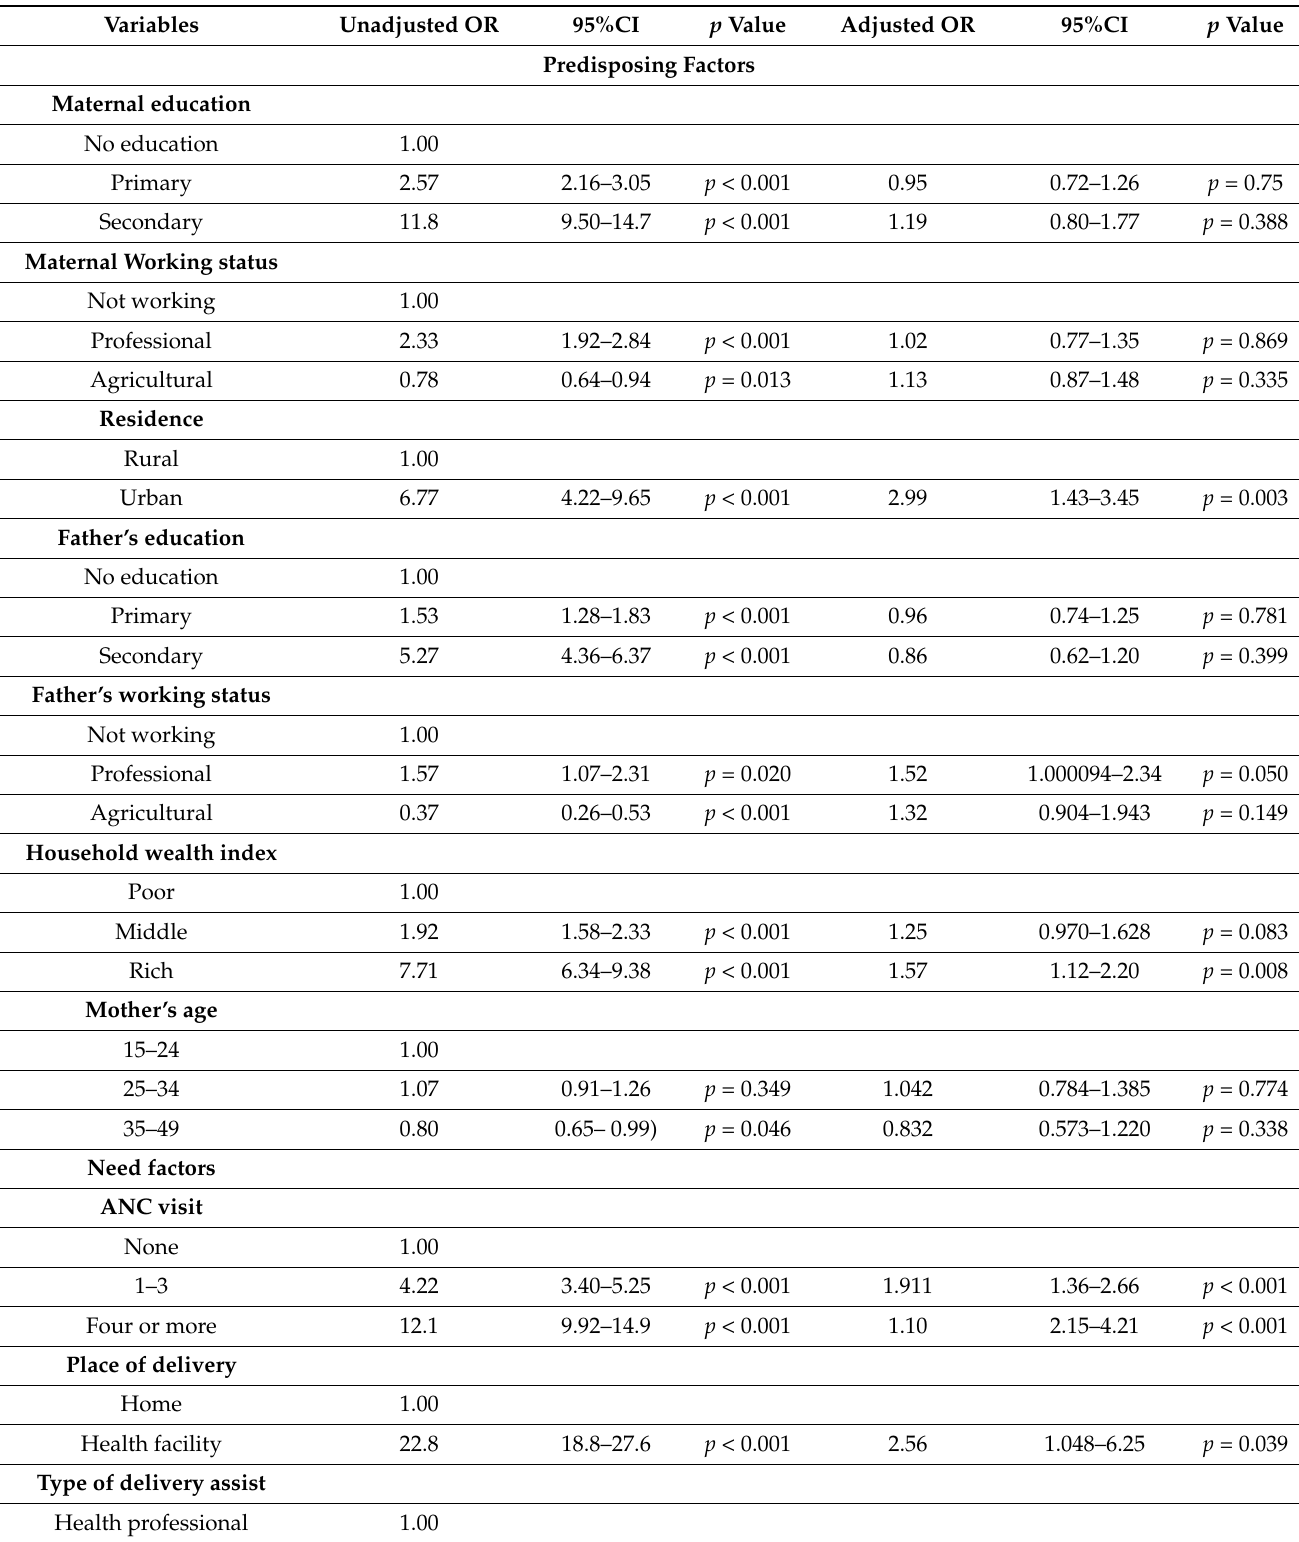
Table 2. Determinants of PNC use in Ethiopia (EDHS) 2000–2016 (n =